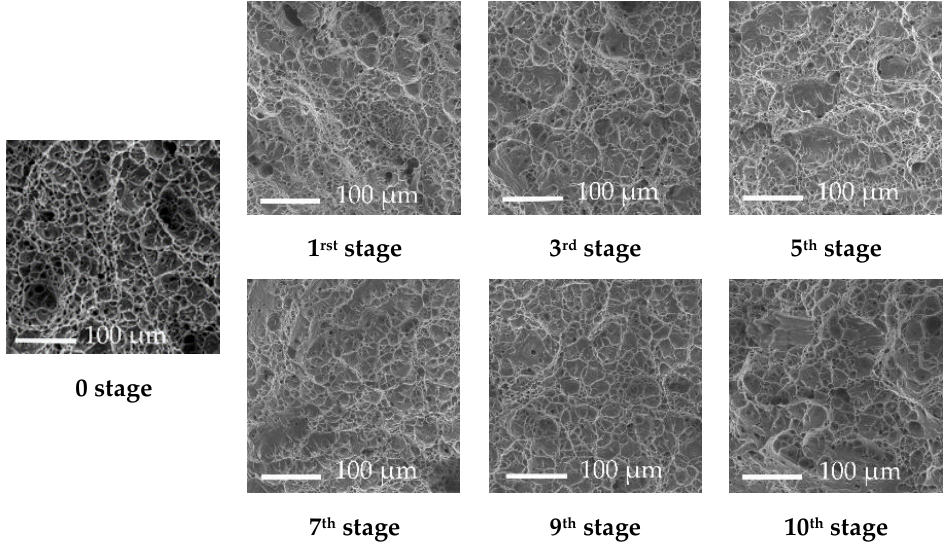
Figure 7. Microscopic images of the surface appearance of the representative samples (250×).